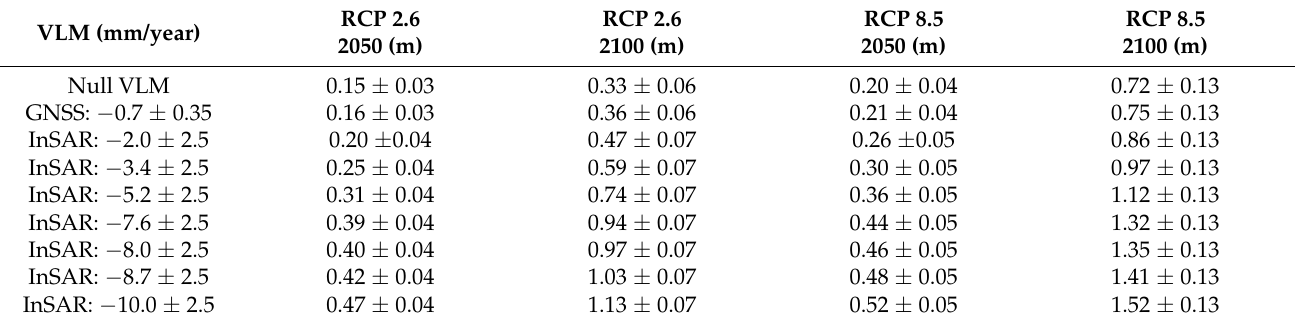
Figure 15. The bay of Vendicari. In colors are reported the expected extension of land flooding in 2050 and 2100 for ( a ) RCP 2.6 and ( b ) RCP 8.5 climatic scenarios for a mean land subsidence at 4 ± 2.5 mm/year. Maximum rate of land subsidence for this area is 10 ± 2.5 mm/year. The expected maximum loss of land is 1.528 km 2 (high-resolution maps are inserted in Supplementary Materials Maps S12 and S13). Table 1. Relative sea-levels projections for RCP 2.6 and RCP 8.5 scenarios for 2050 and 2100 with respect to 2016, for different VLM rates observed in this study in south-eastern Sicily. Uncertainties define the 90% confidence limits. Different cases are considered for: (i) null vertical land motion (only the contribution of GIA already included in the SROCC projections is considered); (ii) mean VLM at − 0.7 ± 0.35 mm/year derived by GNSS data and (iii) observed values of VLM estimated by InSAR analysis along the coastal zones reported in Figure